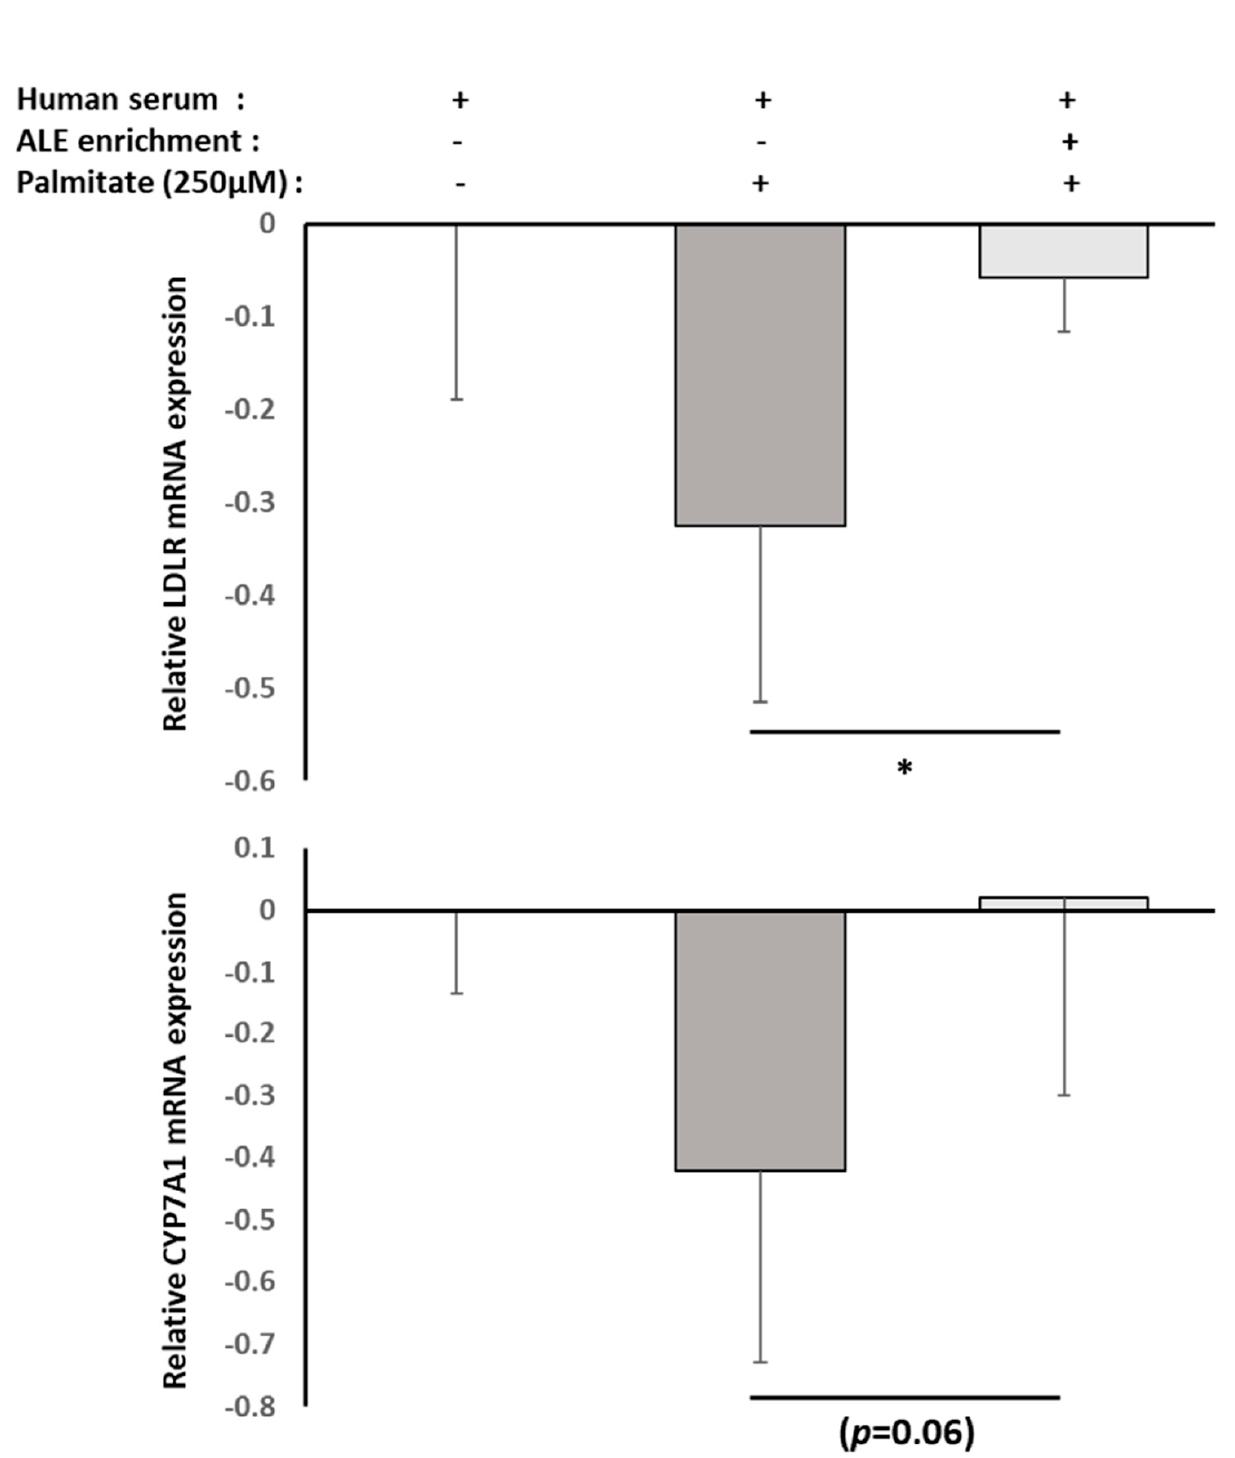
Figure 7. Effect of human serum enriched with ALE metabolites on LDLR and CYP7A1 mRNA expression levels in HepG2 cells. HepG2 cells were preincubated with human serum enriched with ALE metabolites for 24 h and stimulated with palmitate (250 µ M) for an additional 48 h ( − absence; + presence). LDLR and CYP7A1 mRNA expression levels in HepG2 cells were measured by RT-PCR (PowerUp SYBRgreen, Applied Biosystems). β -Actine was used as a housekeeping